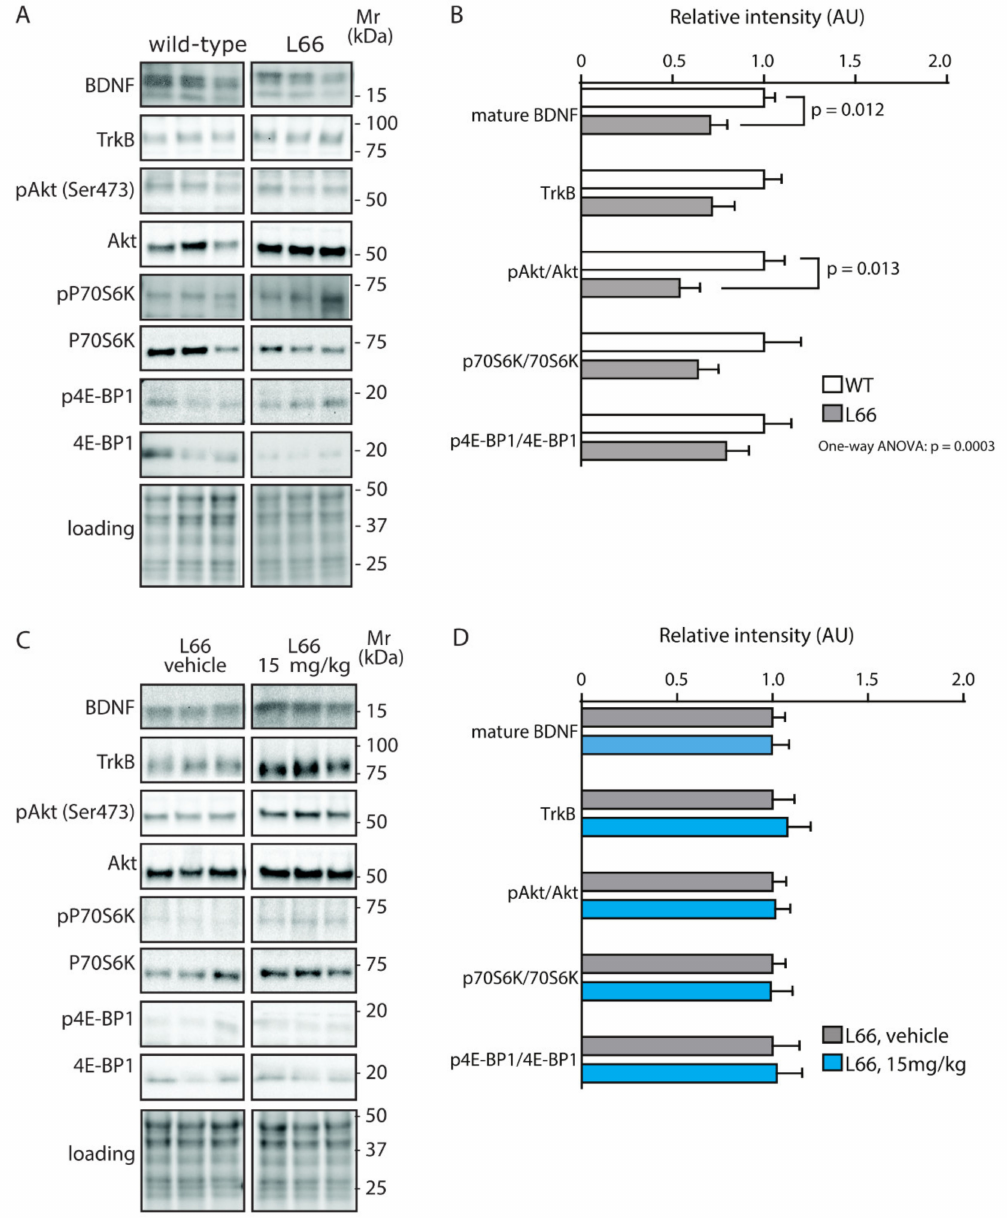
Figure 7. Quantification of BDNF/PI3K-AKT-mTOR activity in mice. Representative immunoblots for ( A ) wild-type and L66 mice and ( C ) L66 mice treated with vehicle or LMTM (15 mg/kg). The proteins were separated by Tris-glycine SDS-PAGE and immuno-detection conducted using the antibodies specified. ( B , D ) Densitometric quantification of these proteins was normalised to total protein loading and values expressed as group mean ± S.E. Statistical analyses were conducted using unpaired t-test and one-way ANOVA for n = 8–12 ( B ) and n = 11–14 mice ( D ) per group. WT: wild-type. Original blot images are shown in the Supporting